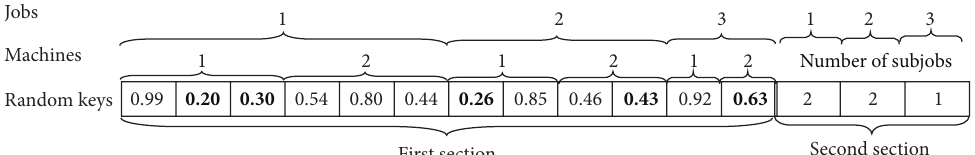
Figure 1: Representation of a chromosome in the GA.